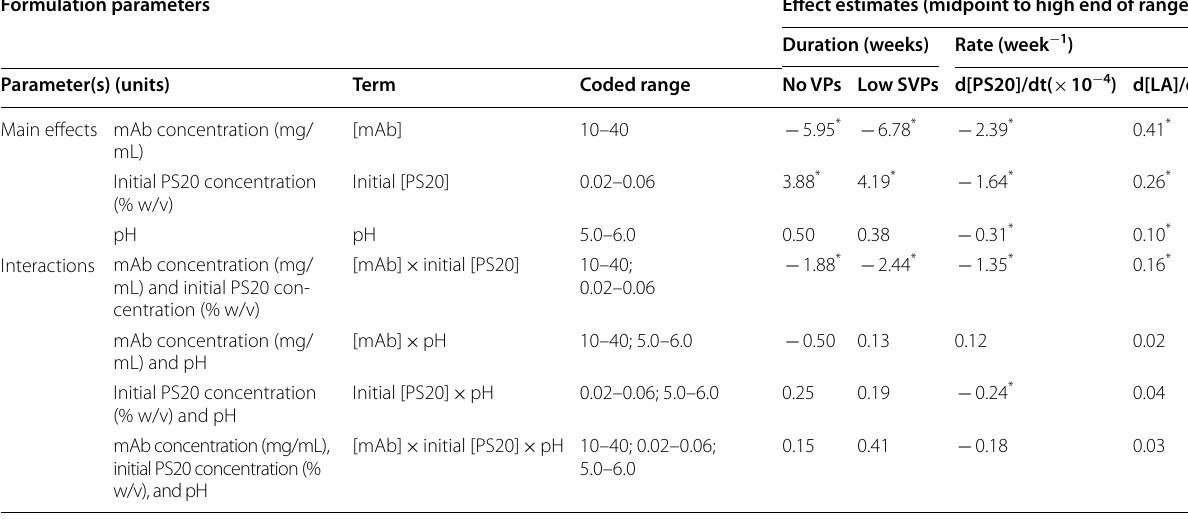
Table 2 Effect estimates for three formulation parameters and their interactions on particle formation and PS20 degradation. The formulation parameters—[mAb], initial [PS20], and pH—were tested in a DP stability study at 5 °C with a full‑factorial design. Particle formation was evaluated as duration with no VPs (by the Ph. Eur./USP method) and duration with low SVPs (< 350 counts for particles/mL by HIAC liquid particle counter). PS20 degradation was quantified by measuring [PS20] in % w/v by HPLC‑ELSD (Fig. 6) and [LA] in µg/mL by LC–MS (Fig. 8) over DP storage. The rate of PS20 change (d[PS20]/dt; Fig. 7) and rate of LA change (d[LA]/dt; Fig. 9) were calculated using the derivatives from fitting to a longitudinal